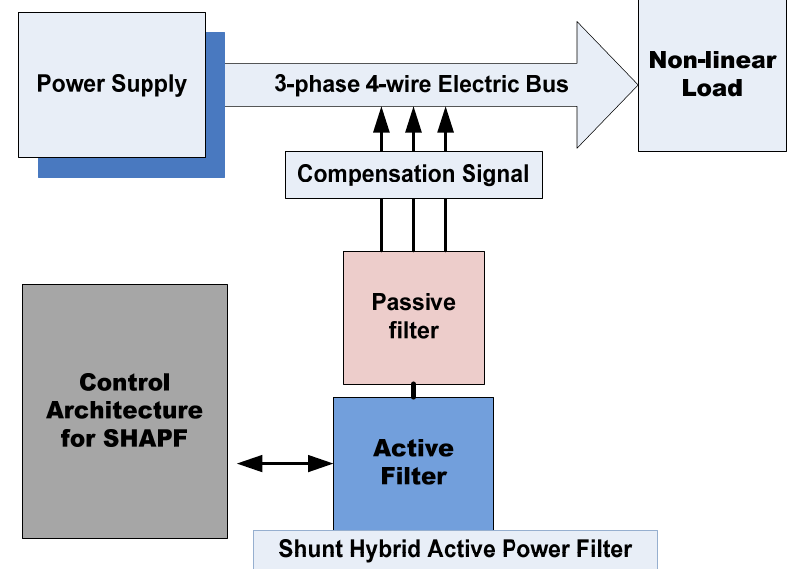
Figure 1. Proposed system overview.